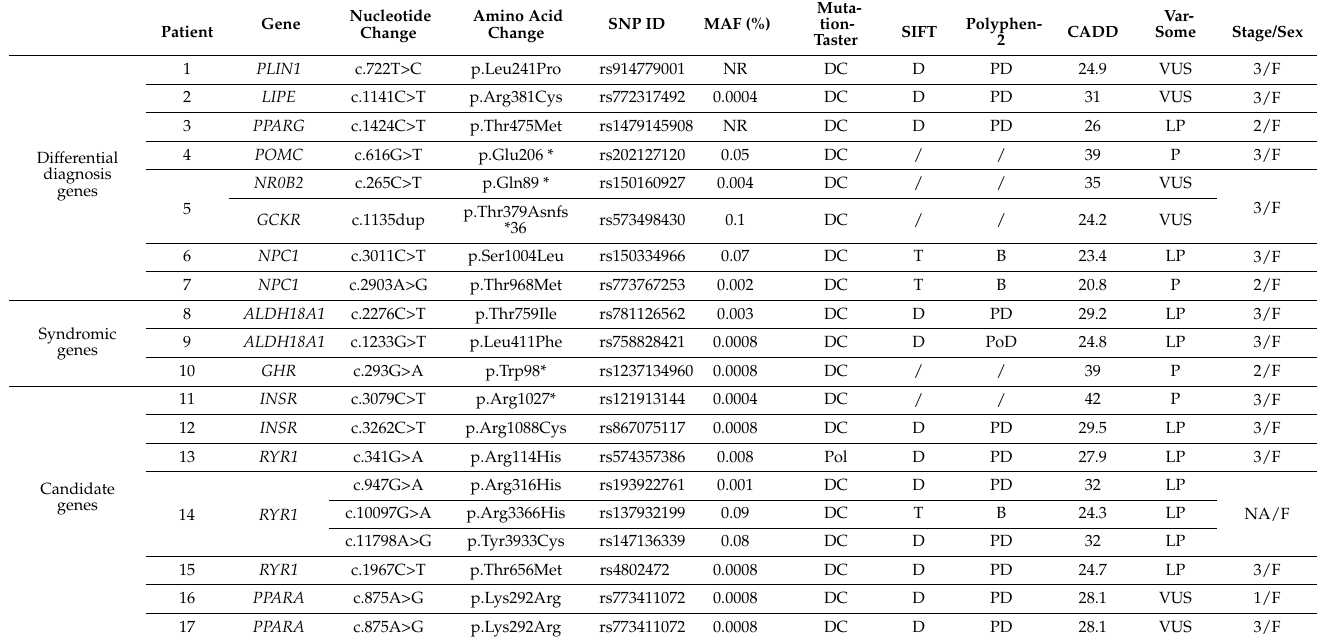
Table 1. Variants identified in the analyzed patients. All variants were heterozygous. * = Pre- mature stop codon; B = benign; D = deleterious; DC = disease causing; LP = likely pathogenic; NR = not reported; P = pathogenic; PoD = possibly damaging; PD = probably damaging; T = toler- ated; VUS = variant of unknown significance. Transcript isoforms: PLIN1 = NM_001145311.2; LIPE = NM_005357.4; ALDH18A1 = NM_002860.4; PPARG = NM_015869.5; GHR = NM_000163.5; INSR = NM_000208.4; RYR1 = NM_000540.3; NPC1 = NM_000271.5; POMC = NM_000939.4; NR0B2